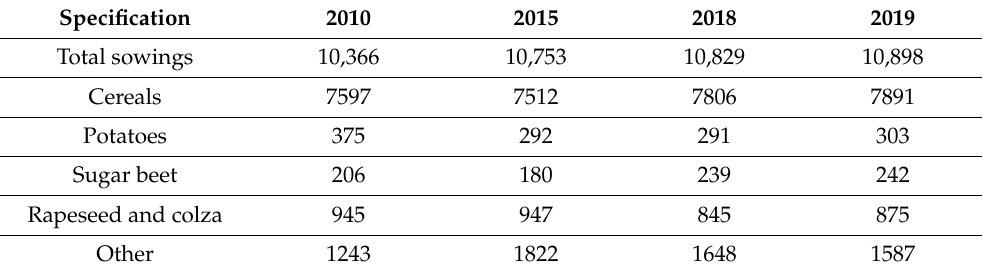
Table 3. General characteristics of the sowing area in Poland in 2010–2019 (thousand ha) [52].